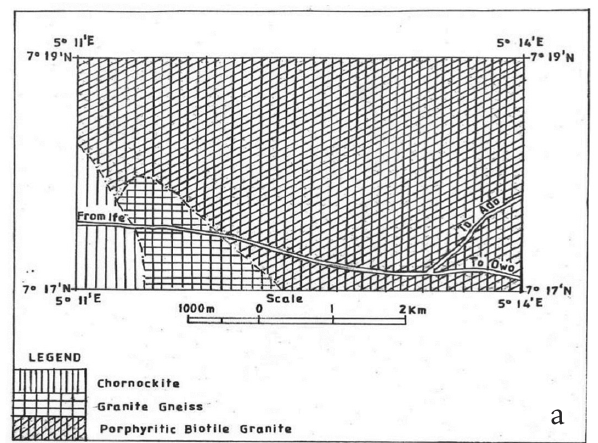
Figure 2 (above and below). (a) Geological map of Irese area Akure, SW Nigeria; (b) Geophysical data acquisition